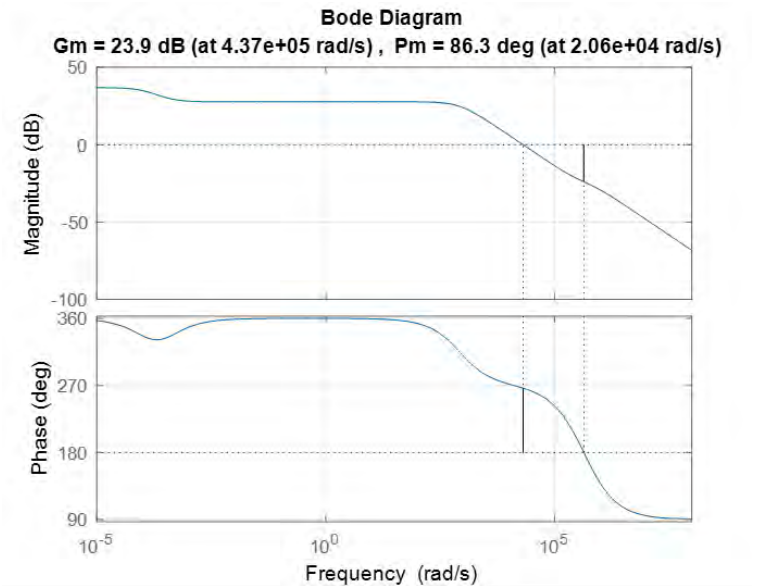
Figure 9. Bode plot of the output voltage transfer